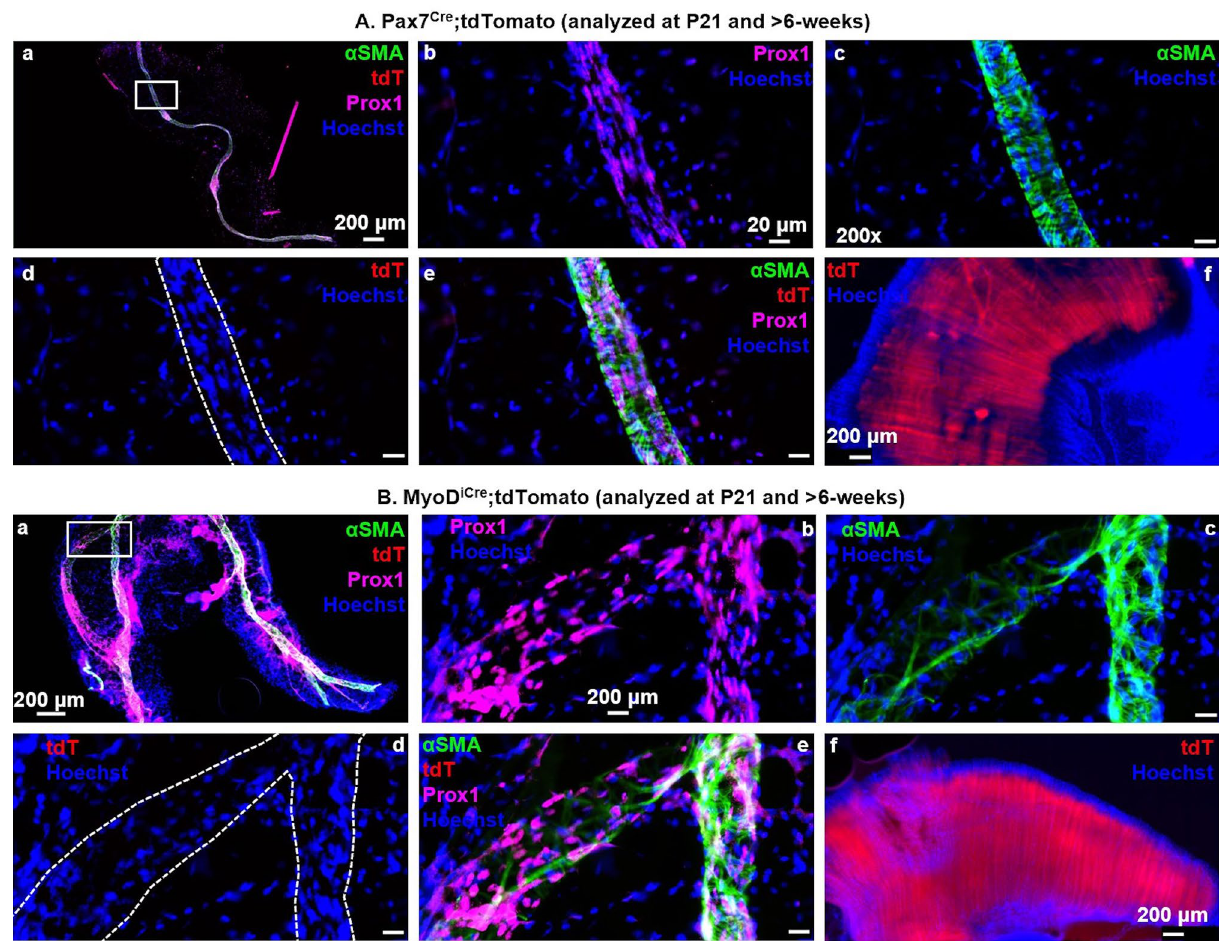
Figure 2. PLV-LMCs do not derive from skeletal muscle progenitor cells during development. Multicolor fluorescent microscopy was performed on whole mount immunostained PLVs from constitutive Pax7 Cre (n = 7, P200 depicted) and MyoD iCre (n = 3, P21 depicted) reporter mice as described in Fig. 1, and direct fluorescent microscopy was performed on Hoechst stained diaphragm tissue from the same muscle-reporter transgenic mice as a positive control. Representative low-magnification images of PLVs with a highlighted region of interest (white boxes) ( A.a , B.a ) are shown with corresponding high-magnification images of Prox1 immunostain of LECs ( A.b , B.b ), αSMA immunostain of LMCs ( A.c , B.c ), the Cre-driven tdT expression (note lack of red fluorescence within the white dotted lines that outline the PLV) ( A.d , B.d ), and overlay of all channels ( A.e , B.e ). Representative images of diaphragm tissue are shown to illustrate the robust Cre-driven tdT expression in skeletal myocytes from these mice ( A.f , B.f